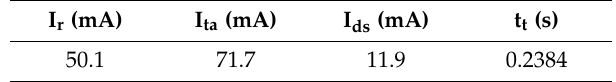
Table 3. Electric parameters for running, transmitting and deep sleep modes.